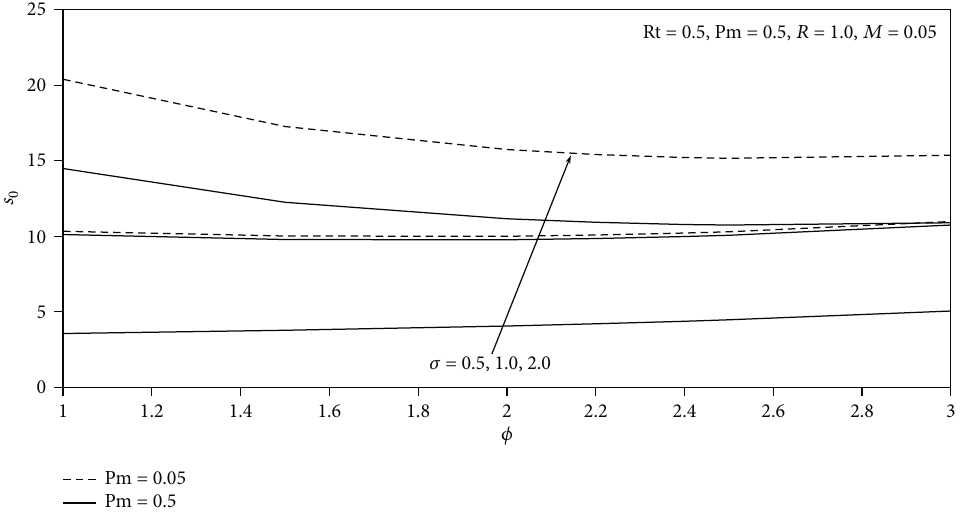
Figure 14: Variation of skin friction ð s